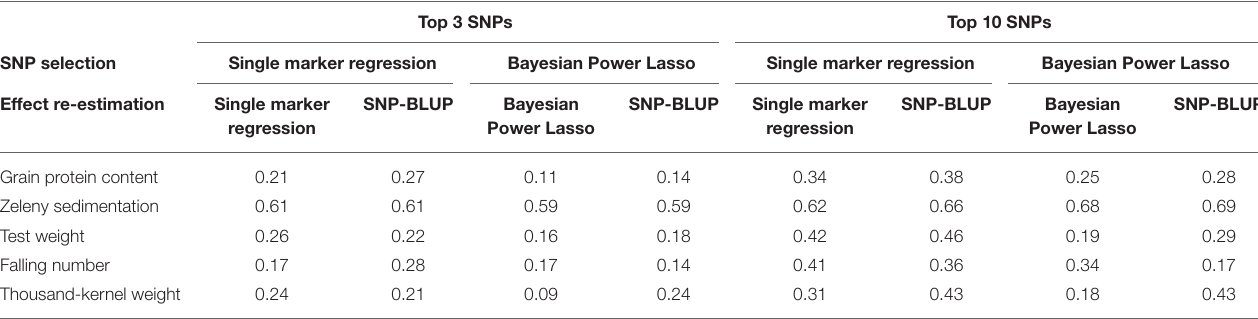
TABLE 8 | Correlations between observed phenotypes corrected for fixed effects and breeding values predicted based on the best three or ten SNPs according to the single marker regression and to the Bayesian Power